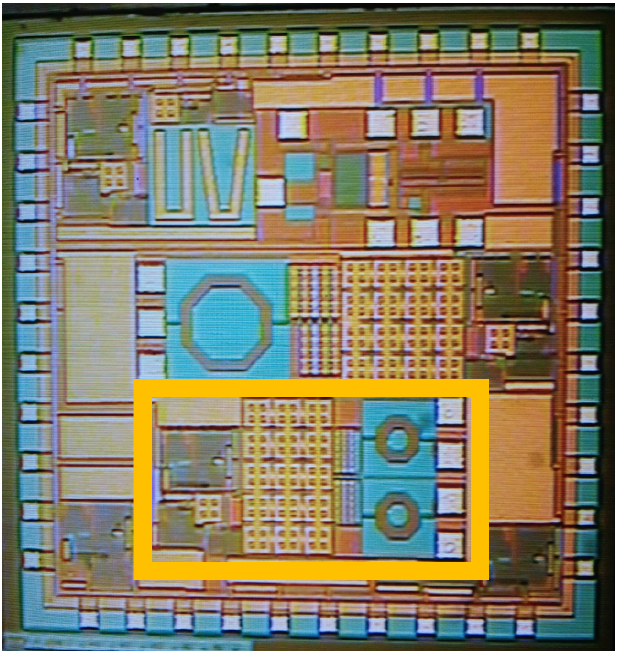
Figure 25. Fabricated prototype of the proposed self-powered temperature sensor.